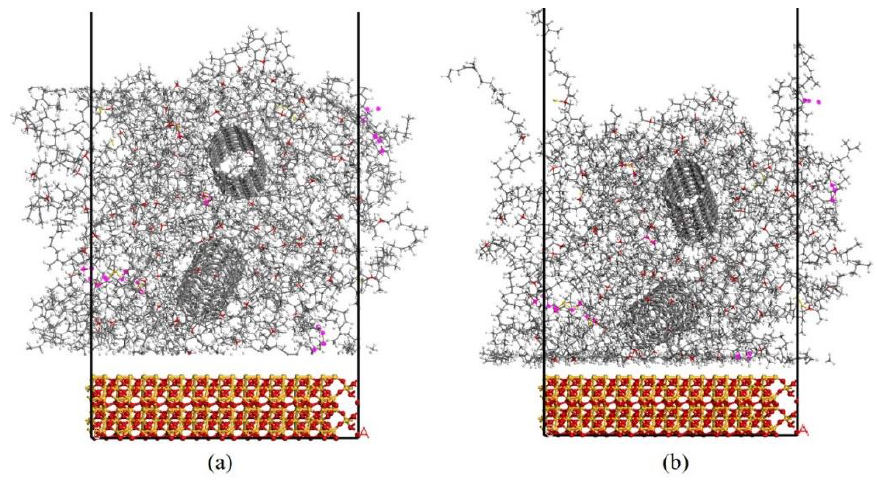
Figure 5. Adsorption double layer structure model of 10 wt.% CNT/VNR composite (Periodic boundary conditions are shown as black lines). ( a ) Initial state. ( b ) Equilibrium state. Additionally, all atoms of SiO 2 layer needs to be unfixed before the